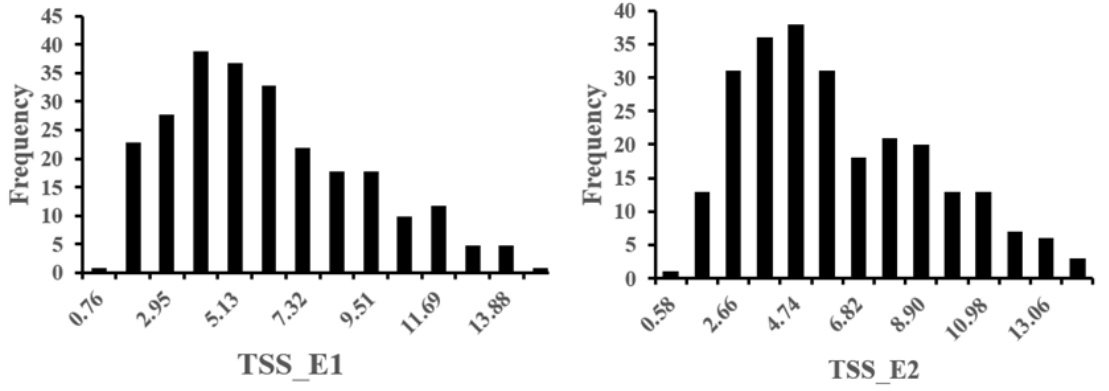
Figure 1. Frequency distribution of the total soluble sugar (TSS) in E1 and E2. E1: total soluble sugar in 2019; E2: total soluble sugar in 2020.